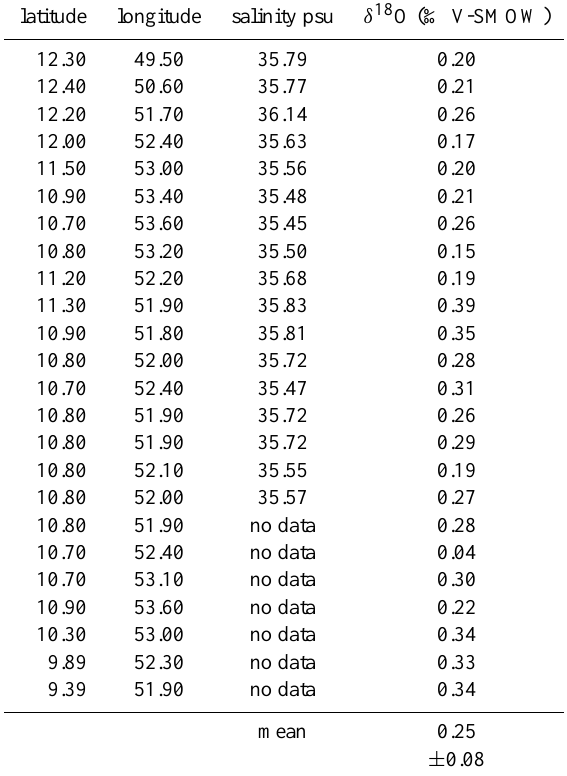
Table 2a. Mg/Ca data for G. ruber in three different size fractions. fraction